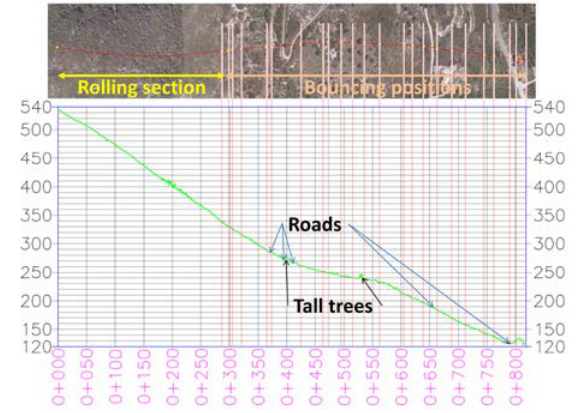
Figure 5. Profile view of rockfall path (units in m)